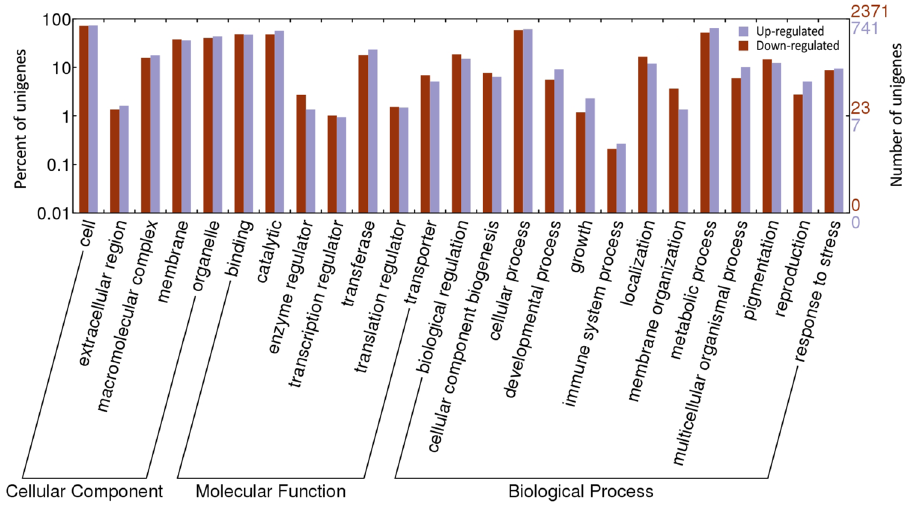
Figure 3. WEGO annotation plot of DEGs in Rafflesia cantleyi . The percentage and number of unigenes of each GO terms are indicated by the left and right x-axis, respectively. GO categories are indicated by the